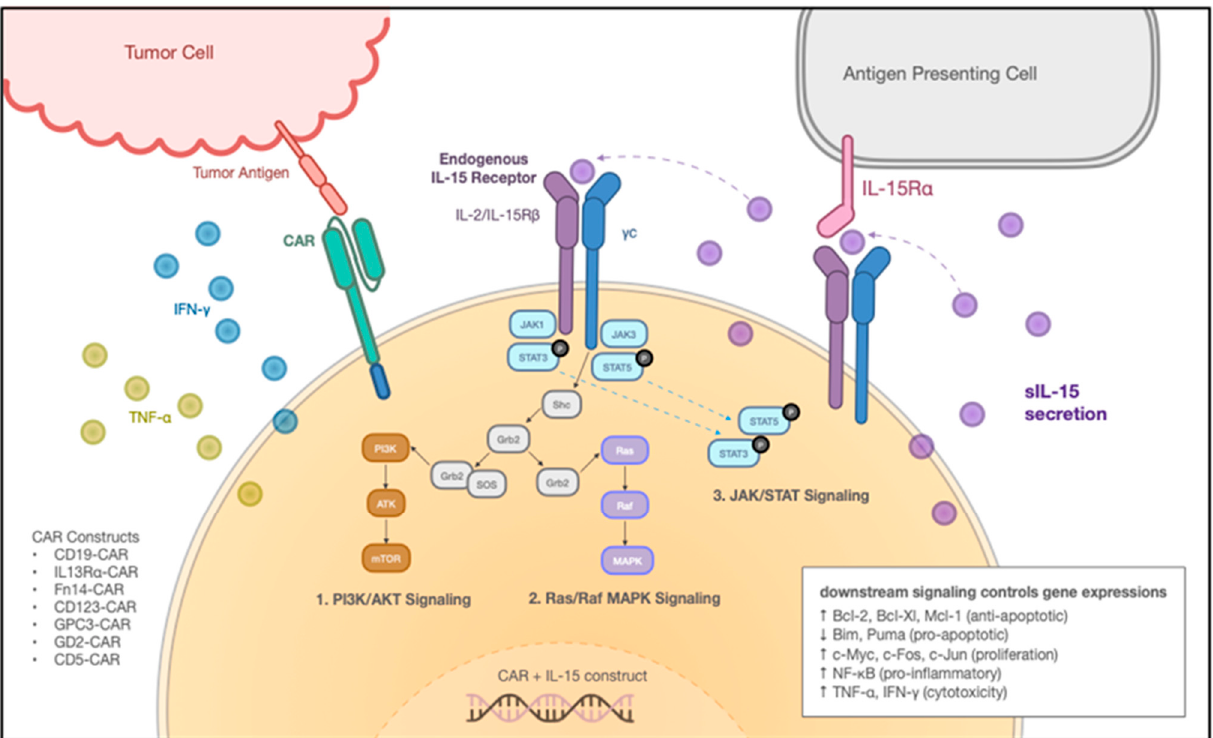
Figure 2. Mechanism of IL-15 Armored CAR T Cells. IL-15-armored CAR T cells mechanism of action. The engineered cells with the CAR and IL-15 transgene secrete soluble IL-15 (sIL-15), which either gets recognized directly by the endogenous IL-15 receptor or captured by neighboring Antigen Presenting Cells (APCs). After receiving the IL-15 signal, downstream signaling pathways include the PI3K/AKT signaling pathway, Ras/Raf MAPK signaling pathway, and JAK/STAT signaling pathway. These three pathways together control various gene expressions: upregulating Bcl-2, Bcl-Xl, Mcl-1 (anti-apoptotic), downregulating Bim, Puma (pro-apoptotic), upregulating c-Myc, c-Fos, c-Jun (proliferation), NF- κ B (pro-inflammatory) and inducing the release of TNF- α , IFN- γ (cytotoxicity). On the left is a diagram representation of tumor recognition through CAR. CAR constructs include CD19-CAR, IL13R α -CAR, Fn14-CAR, CD123-CAR, GPC3-CAR, GD2-CAR, and CD5-CAR et